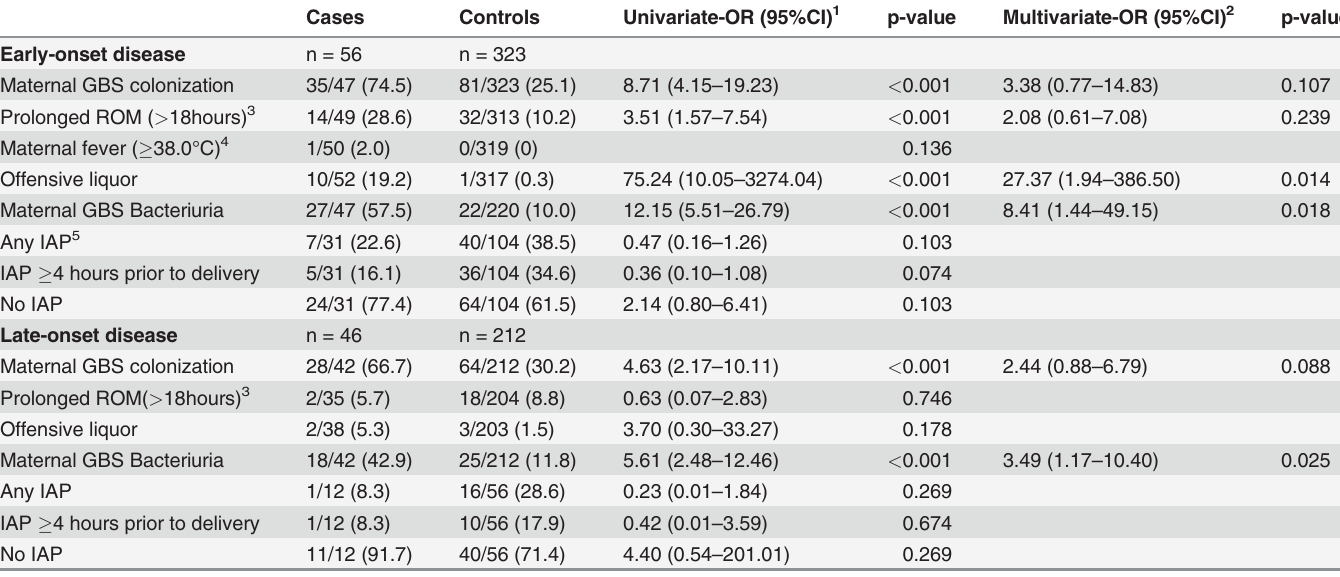
Table 2. Risk factors for invasive Group B Streptococcal (GBS) disease in early-onset and late-onset disease cases and matched controls. Cases